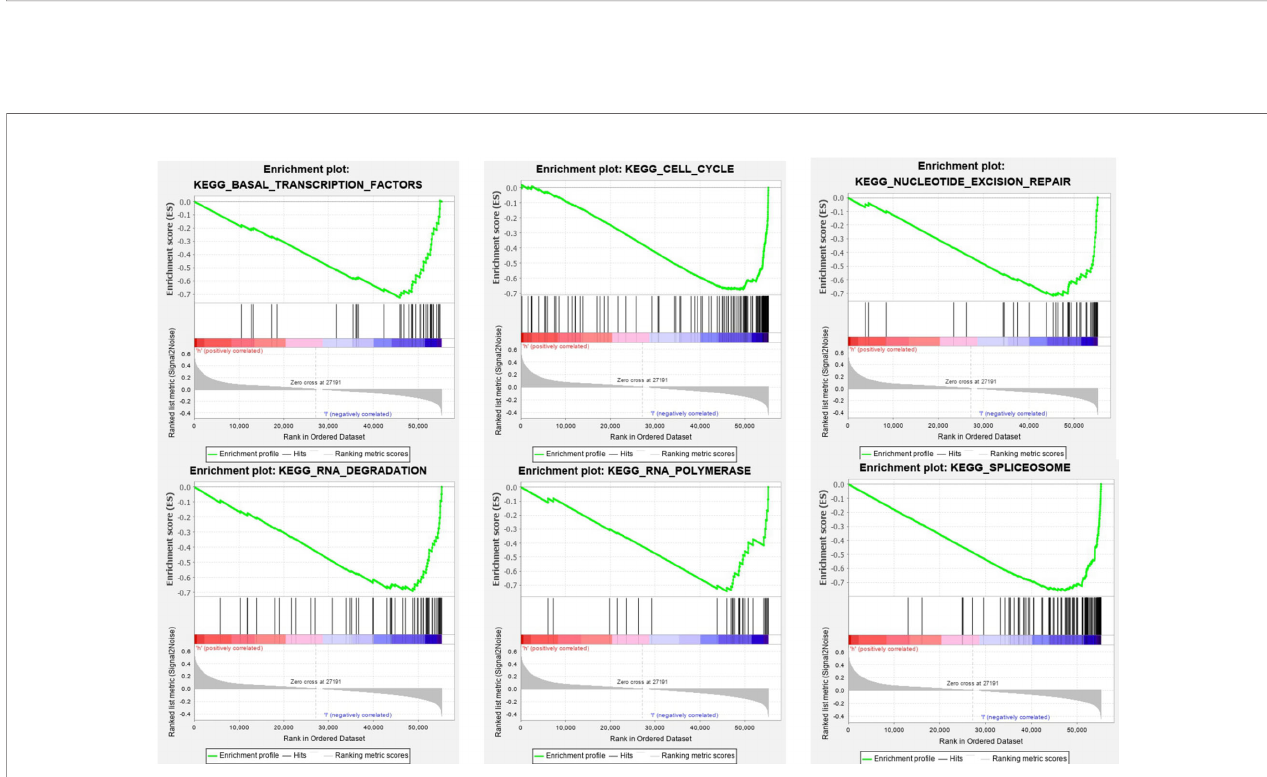
FIGURE 5 | GSEA Enrichment plots. GSEA outcomes on the display of differential enrichment of genes in lung cancer cases with high SOD3 expression, involving basal transcription factors, cell cycle, nucleotide excision repair, RNA degradation, RNA polymerase, spliceosome.